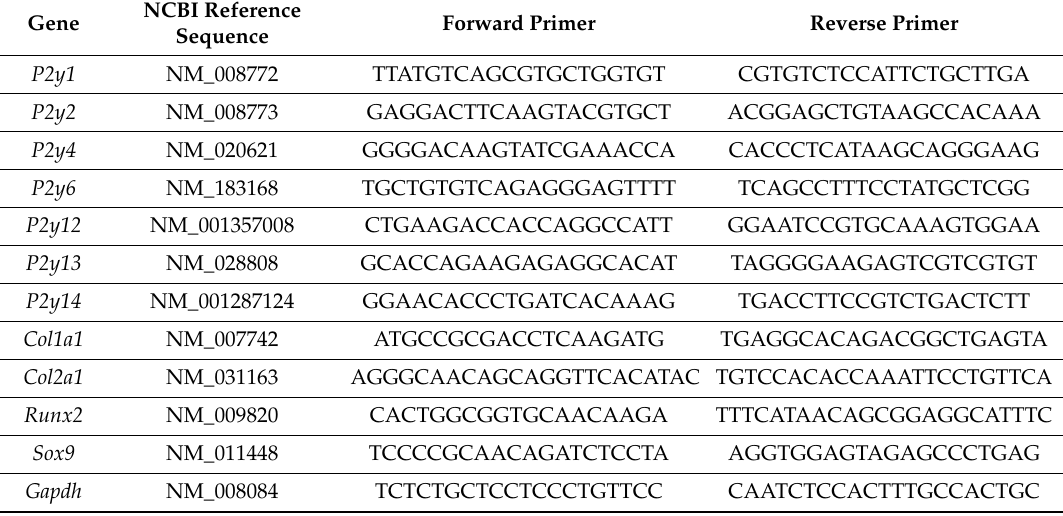
Table 1. Sequence of primers used in RT-qPCR